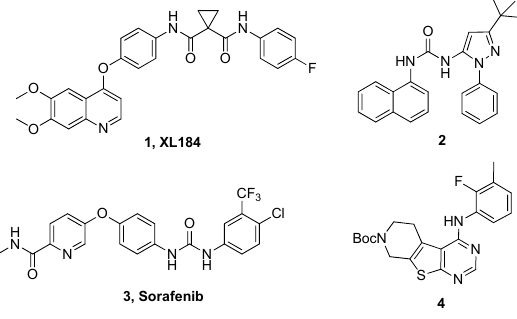
Figure 1. Representative c-MET inhibitor ( 1 , XL184 ) and Multi-kinase inhibitor ( 2 – 4 ). Molecules 2016 , 21 , 612;